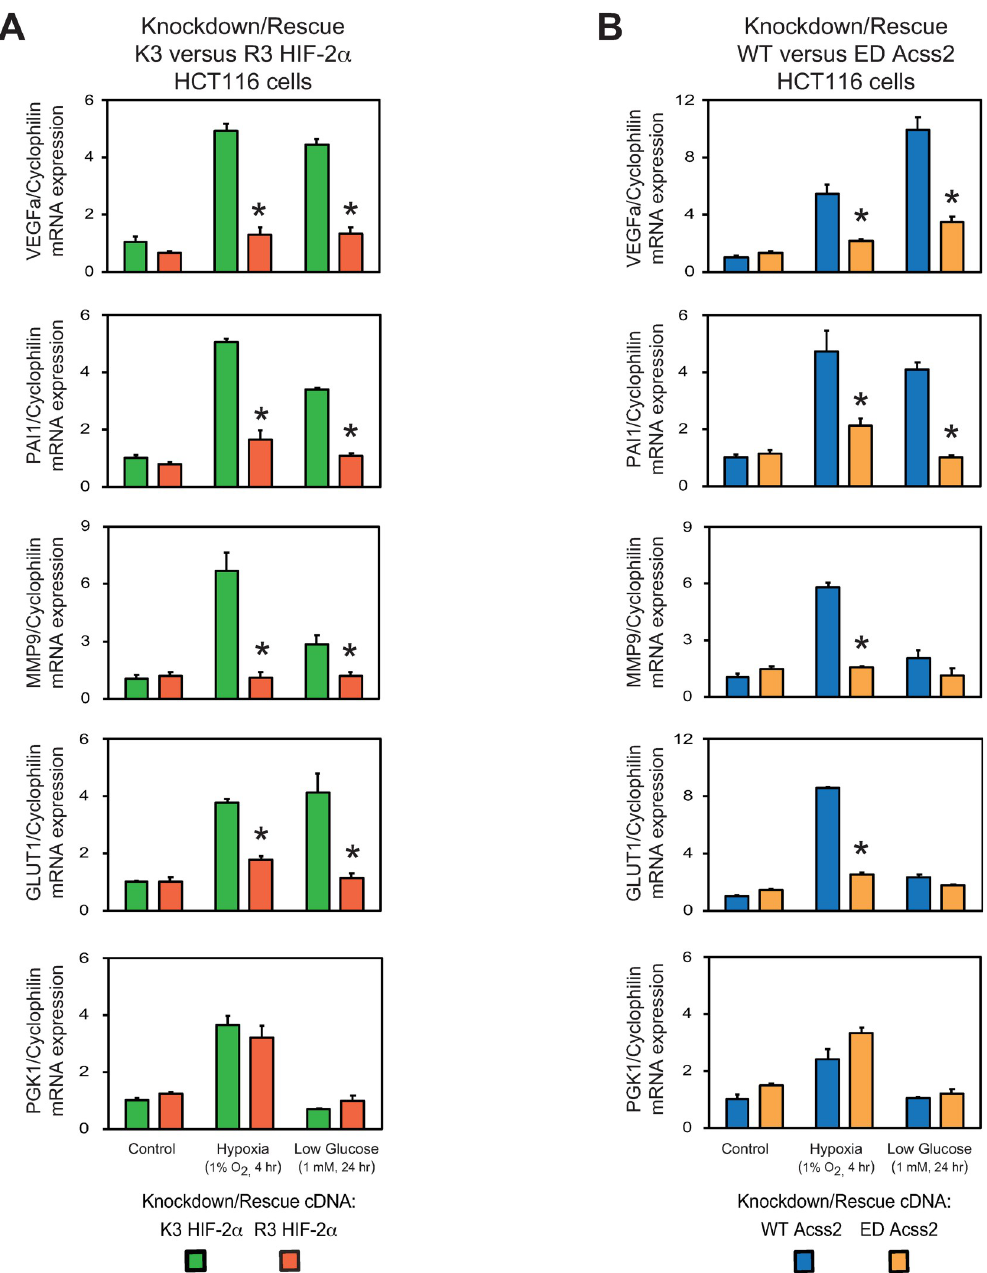
Fig 5. Acss2/HIF-2 regulates cancer-associated factors in HCT116 cells. Semi-quantitative RTPCR measurements of HIF- 1 selective (PGK1) target genes in comparison with HIF-2 preferential or HIF-1/HIF-2 co-regulated (VEGFa, PAI1, MMP9, GLUT1) target genes in (A) HIF-2 α knockdown HCT116 cells rescued with wild-type (K3) or arginine-lysine substituted mutant (R3) HIF-2 α , or (B) Acss2 knockdown HCT116 cells rescued with wild-type (WT) or cytosol-restricted mutant (ED) Acss2, after the indicated period of hypoxia exposure or glucose deprivation. Comparison of samples within a given condition was performed by one-way ANOVA followed by Dunnett’s multiple comparisons test using control shRNA knockdown/control rescue as reference with decreased samples noted ( � , P < 0.05). Values indicated are means with SD.